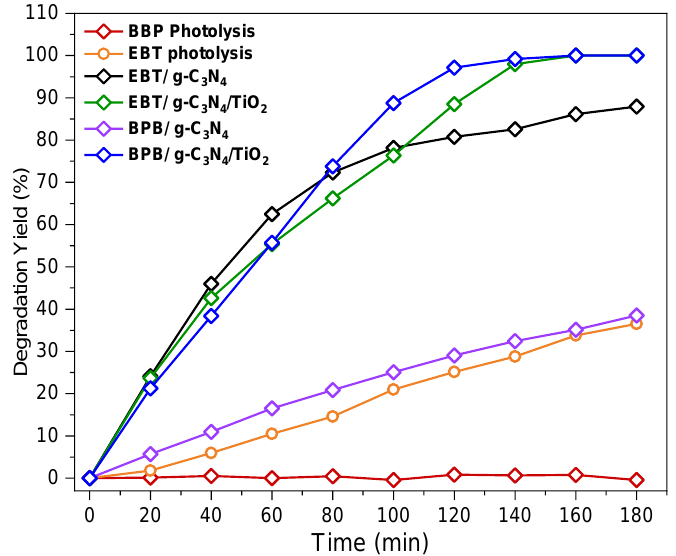
Figure 5. Photodegradation of 500 mL of dye solution (10 ppm) with 200 mg/L of catalyst under UV irradiation and natural pH.